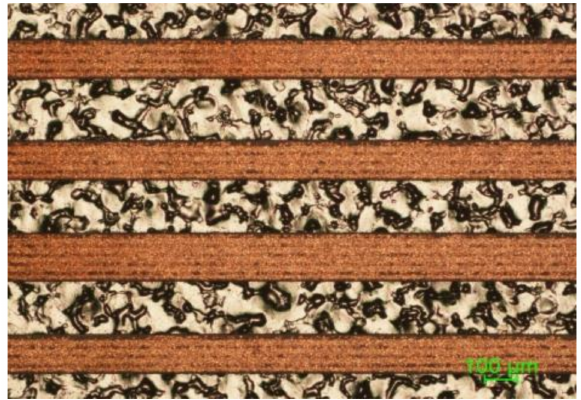
Figure 8. Copper lines after the SSAIL procedure when the Y3 / 2D scanning technique was applied. The average laser power was 5 W.